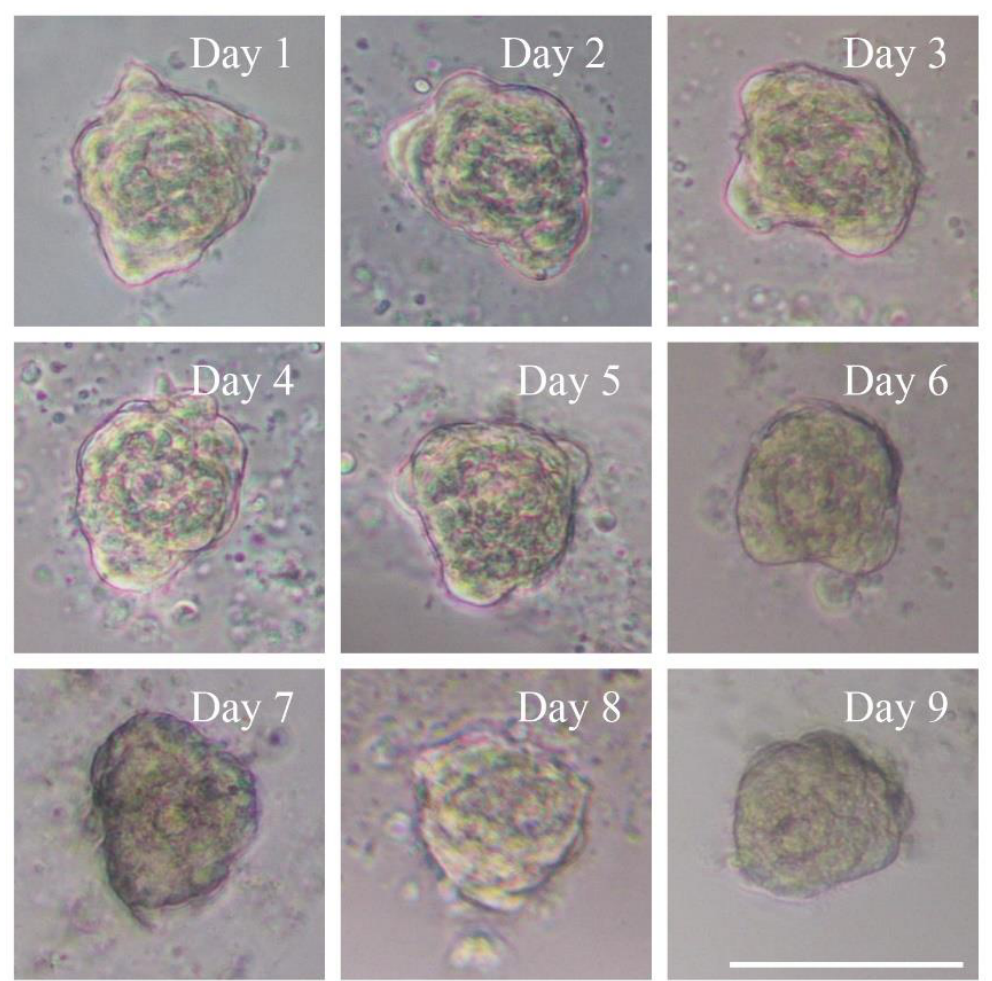
Figure 9. Morphology of multicellular 3D spheroids formation of UC-MSCs from day 1 to day 9. Bar = 100 µm.